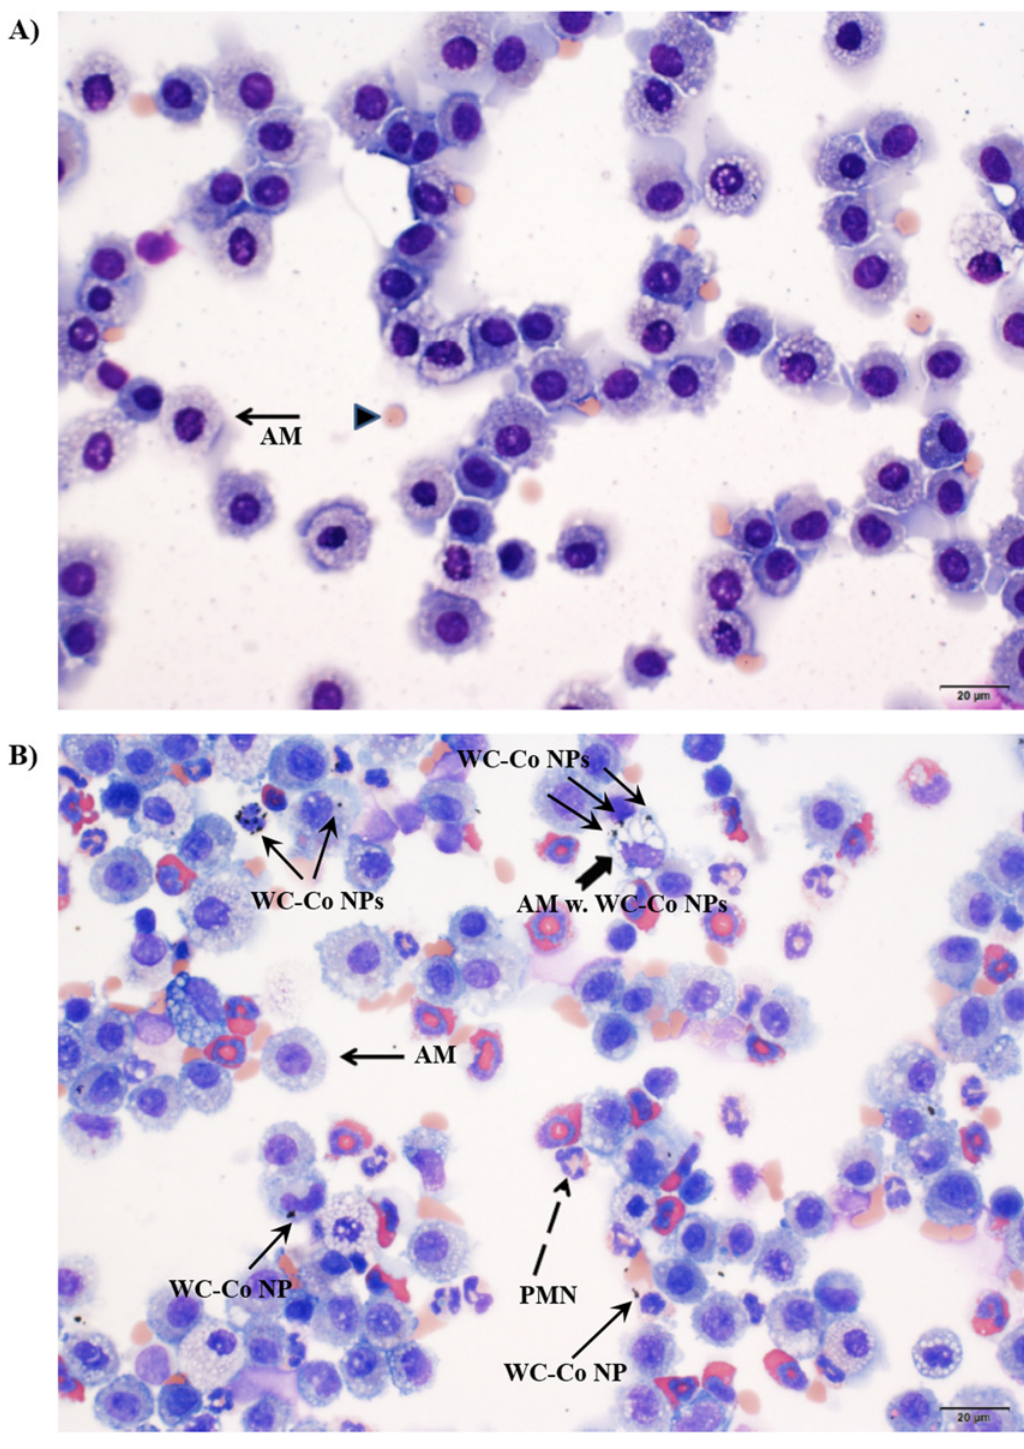
Fig 5. Histology of isolated BAL fluid cells from a representative A) control (vehicle only) rat and B) 500 μ g WC-Co NP exposed rat. Scale bars = 20 μ m. (black arrow = alveolar macrophage, AM; arrow head = erythrocyte; dotted arrow = polymorphonuclear leukocyte, PMN; wide arrow = AM with WC-Co NPs)